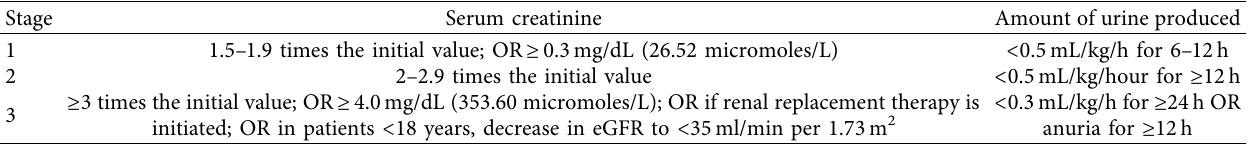
Table 1: KDIGO 2012 staging criteria for acute kidney injury